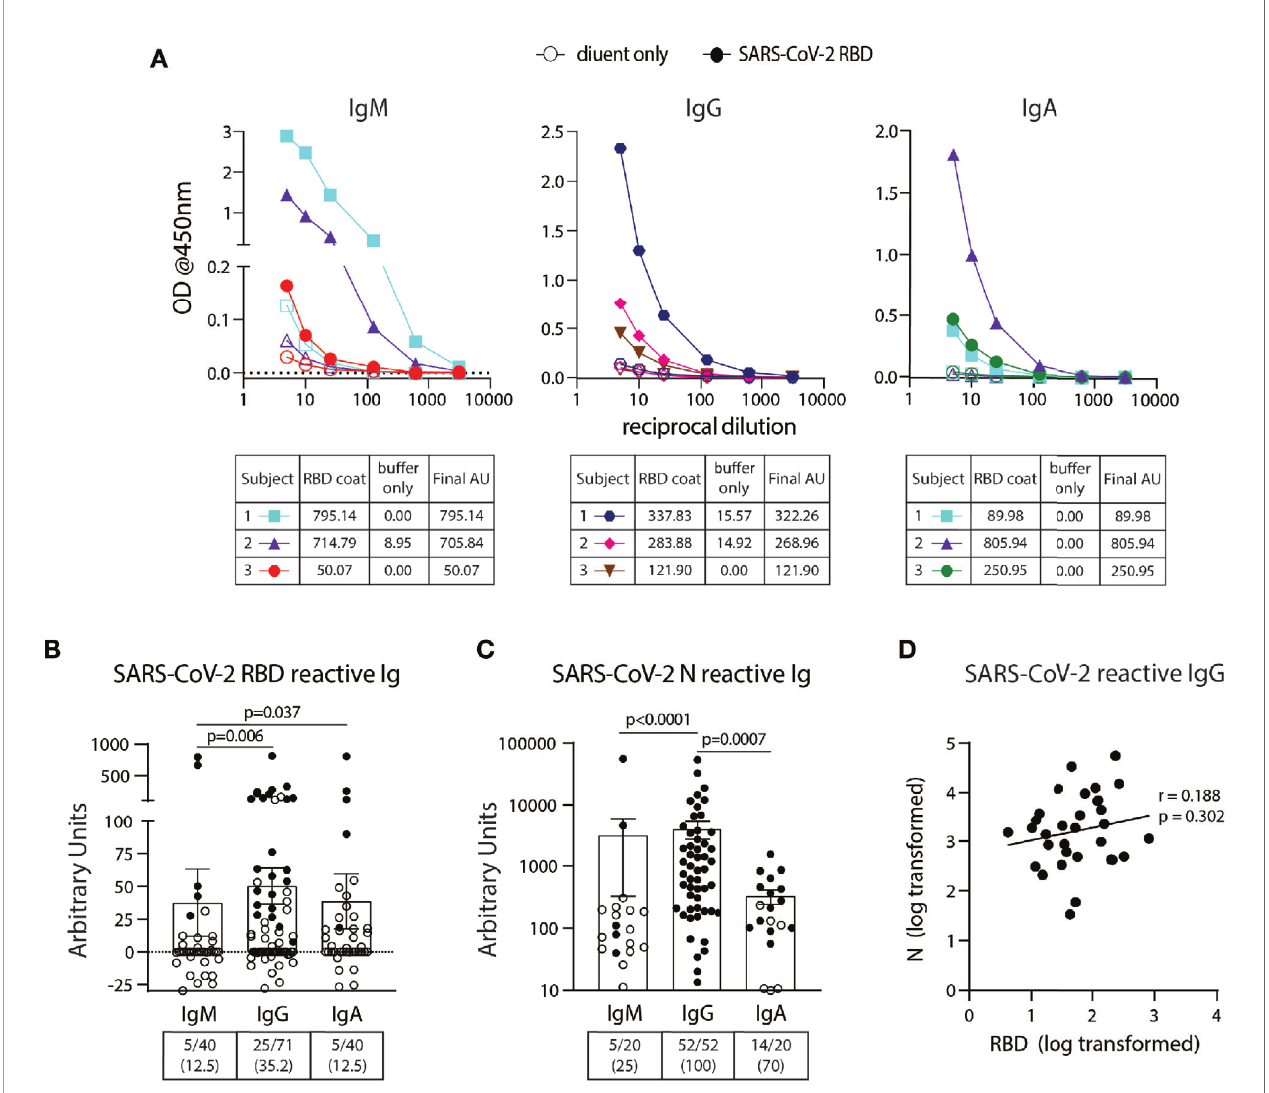
FIGURE 2 | Detection and quanti fi cation of SARS-CoV-2 RBD- and N- reactive antibodies in pre-pandemic samples. (A) Representative dilution curves of seven pre-pandemic samples with SARS-CoV-2 RBD-reactive antibodies (three subjects per graph). Open and solid symbols represent buffer only coat and SARS-CoV-2 RBD coat, respectively. Arbitrary Units (AU) were calculated as described in Methods and shown beneath the respective isotype graph for diluent only and SARS- CoV-2 RBD coat. AUs for SARS-CoV-2 RBD (B) and N (C) reactive IgM, IgG, and IgA in pre-pandemic samples. Open and solid symbols represent negative and positive results, respectively, as determined by Metric 1. Enumeration of the positive samples for each isotype in the pre-pandemic cohort is shown beneath each graph with percentages of total in parentheses. (D) Correlation between AUs for IgG reactive to SARS-CoV-2 RBD and N (n=32). Values were log-transformed to obtain a parametric distribution. Statistical analyses were performed using an unpaired non-parametric Mann-Whitney t-test in (B, C) and Pearson ’ s correlation of normally distributed AU values for (D)